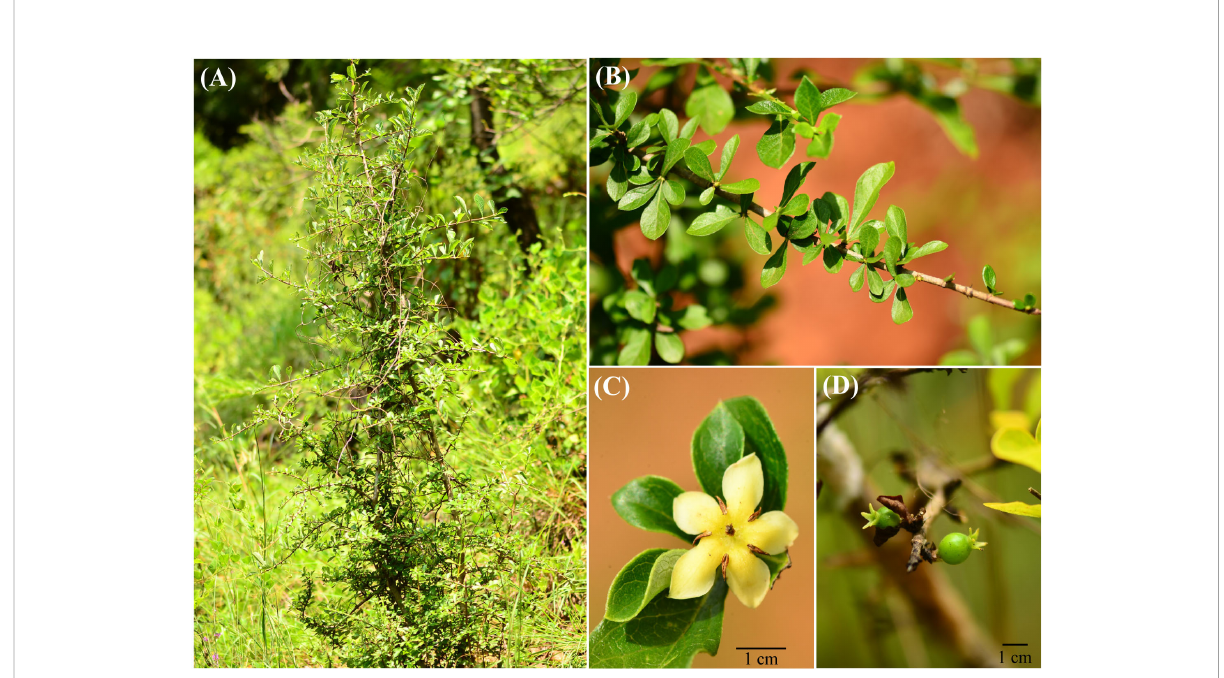
FIGURE 1 Himalrandia lichiangensis (A) Plant and habitat, (B) Leaves, (C) Flower, and (D)